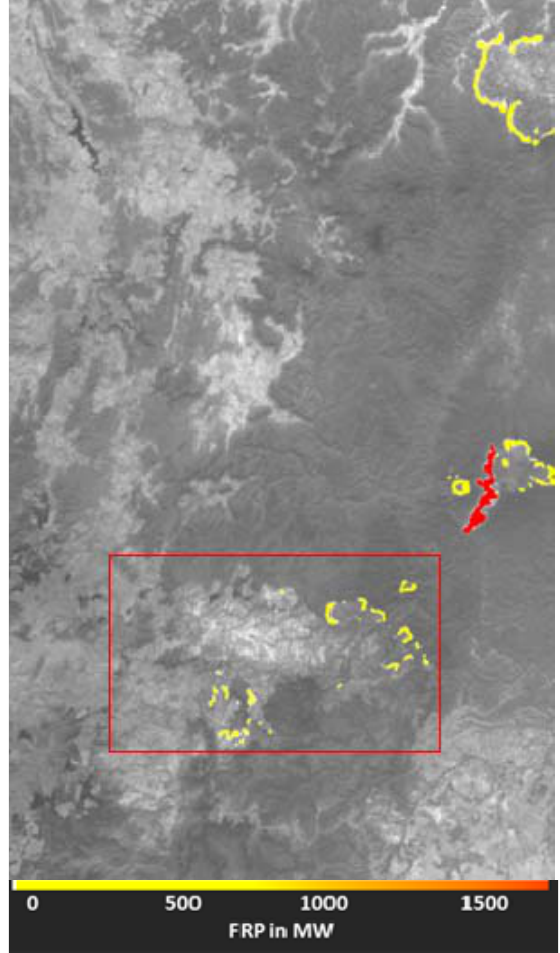
Figure 3: Calculated FRP from TET-1 image (26th Oct. 2013)